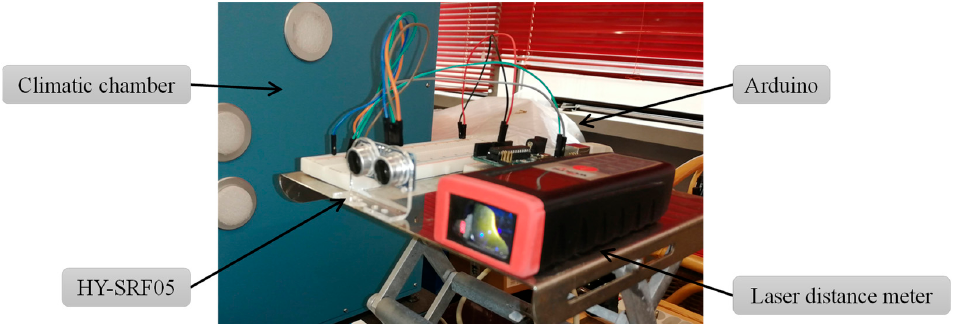
Figure 3. Detail of the experimental setup.